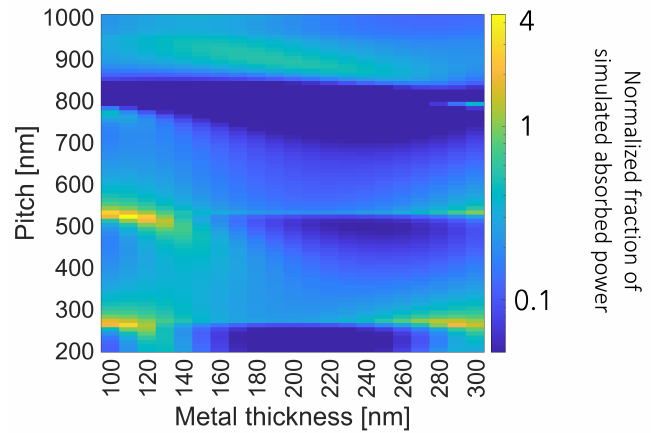
Figure 4. Normalized fraction of simulated absorbed power over the ideal absorption (with null reflection) of a 3µm silicon slab integrated with a plasmonic metal array of a DC of 0.80 over a thin Si 3 N 4 layer of 11nm at the wavelength of 950nm as a function of the pitch and metal thickness.